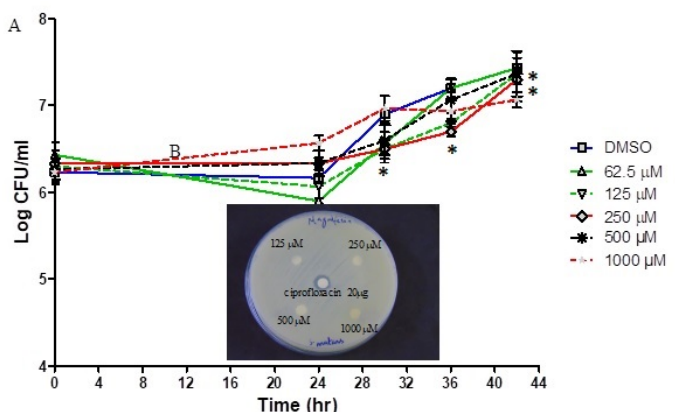
Figure 2. ( A ) Effect of mangiferin on growth pattern of S. mutans planktonic cell cultures using time kill assay. The concentrations of mangiferin ranged from 62.5 µm to 1000 µm. ( B ) Antibacterial effect of mangiferin against S. mutans using disc diffusion method. The DMSO treated S. mutans cells